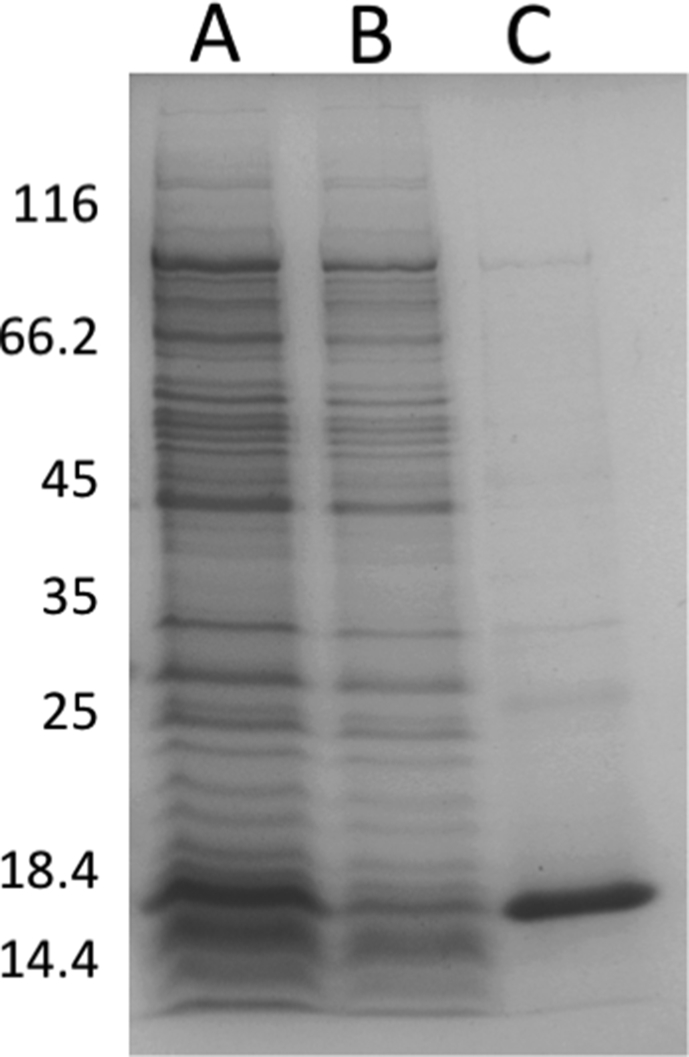
Solubilisation and purification of the Ferrimonas balearica DSM 9799 PACE family protein, Fbal_3166 [3], using styrene maleic acid co-polymer and Ni-affinity purification. Fbal_3166 protein was overexpressed in E. coli BL21 cells grown in a 30 L fermenter using the pTTQ18 expression system [27], [28]. Styrene maleic acid co-polymer preparation, membrane solubilisation and Ni-affinity purification were performed as previously described [17]. Samples consisting of solubilised membrane proteins (lane A), proteins that did not bind to the Ni-affinity column (lane B) and purified Fbal_3166 (lane C) were run on a 15% SDS-PAGE gel and stained with Coomassie brilliant blue R-250. The size (kDa) of co-migrated soluble molecular weight markers is shown on the left side of the gel.